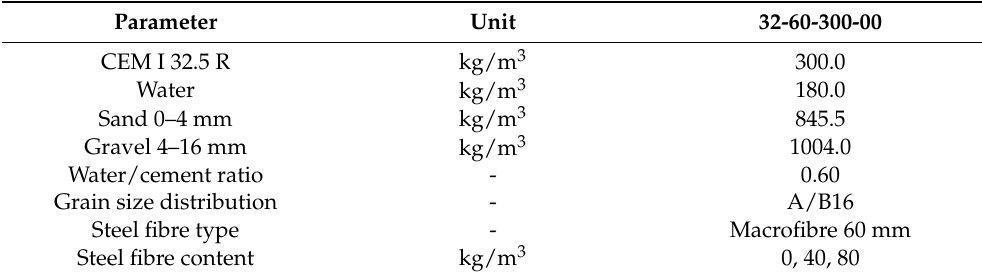
Table 1. Concrete mix design of the basic